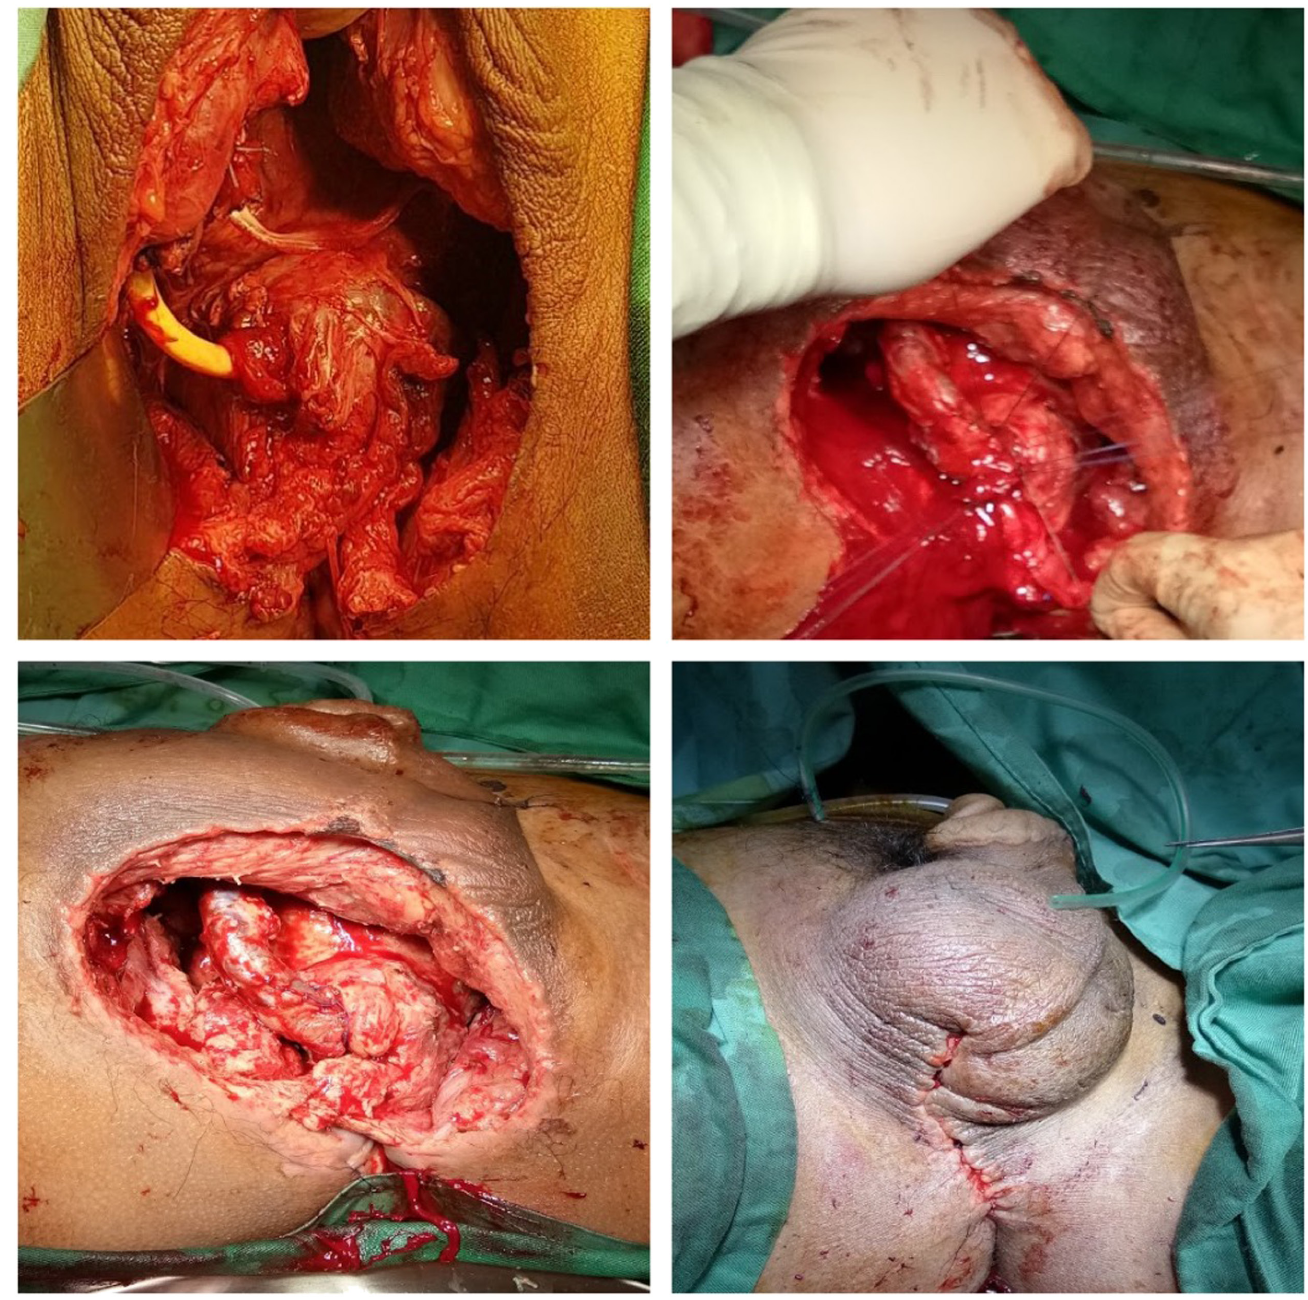
bulbomembranous urethra. Primary anastomotic urethroplasty was done after radical wound debridement. Drain inserted